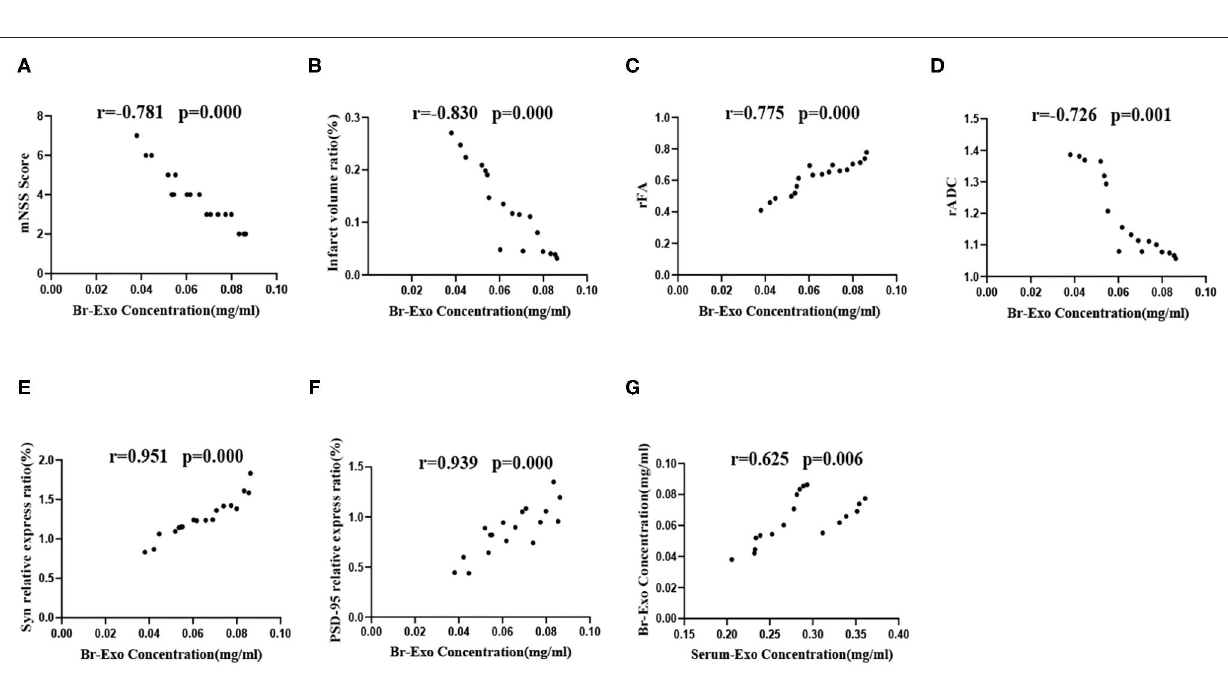
FIGURE 8 | Correlation analysis of brain exosome levels with the mNSS score, infarct volume ratio, rFA value, rADC value, Syn, and PSD-95 protein expression levels. (A–F) Correlation analysis between brain exosome levels and the mNSS score, infarct volume ratio, rFA value, rADC value, Syn, and PSD-95 protein expression level. (G) Correlation analysis between serum exosome and brain exosome concentrations. Serum-Exo concentration: serum exosome concentration, Br-Exo concentration: brain exosome concentration. Means ± standard deviations, n =